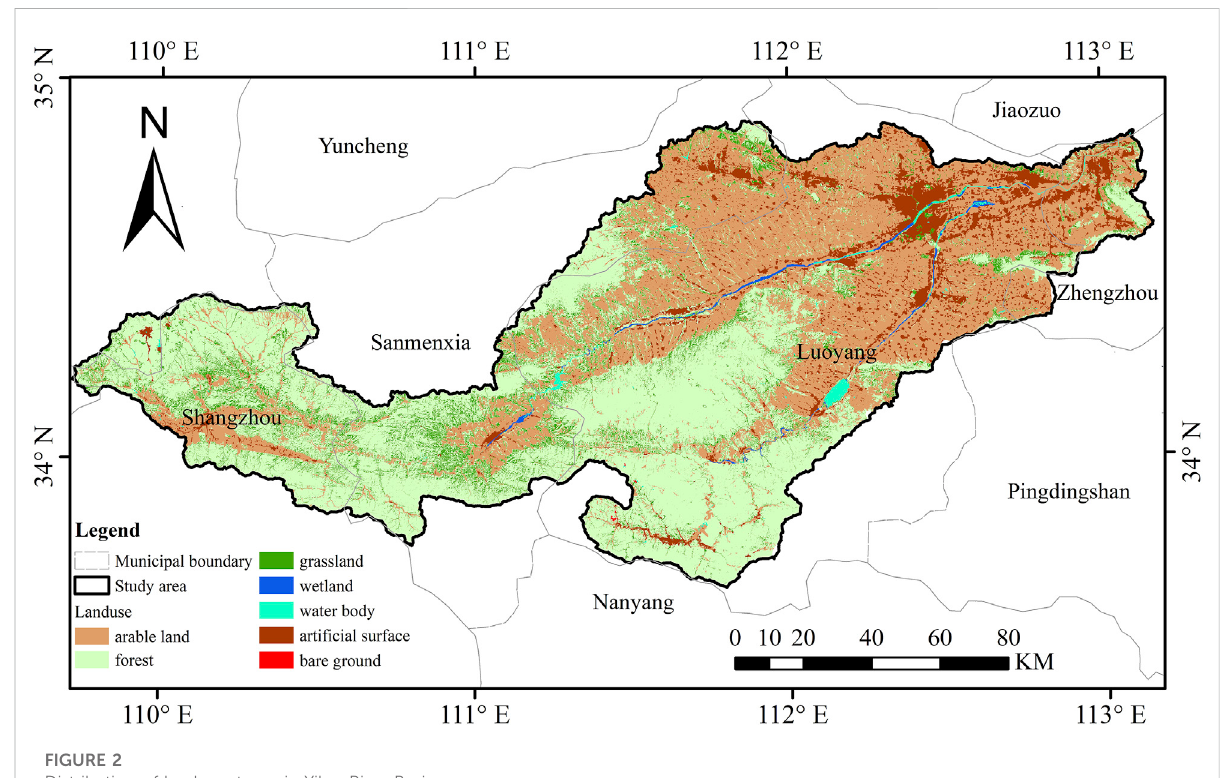
FIGURE 2 Distribution of land use types in Yiluo River Basin.